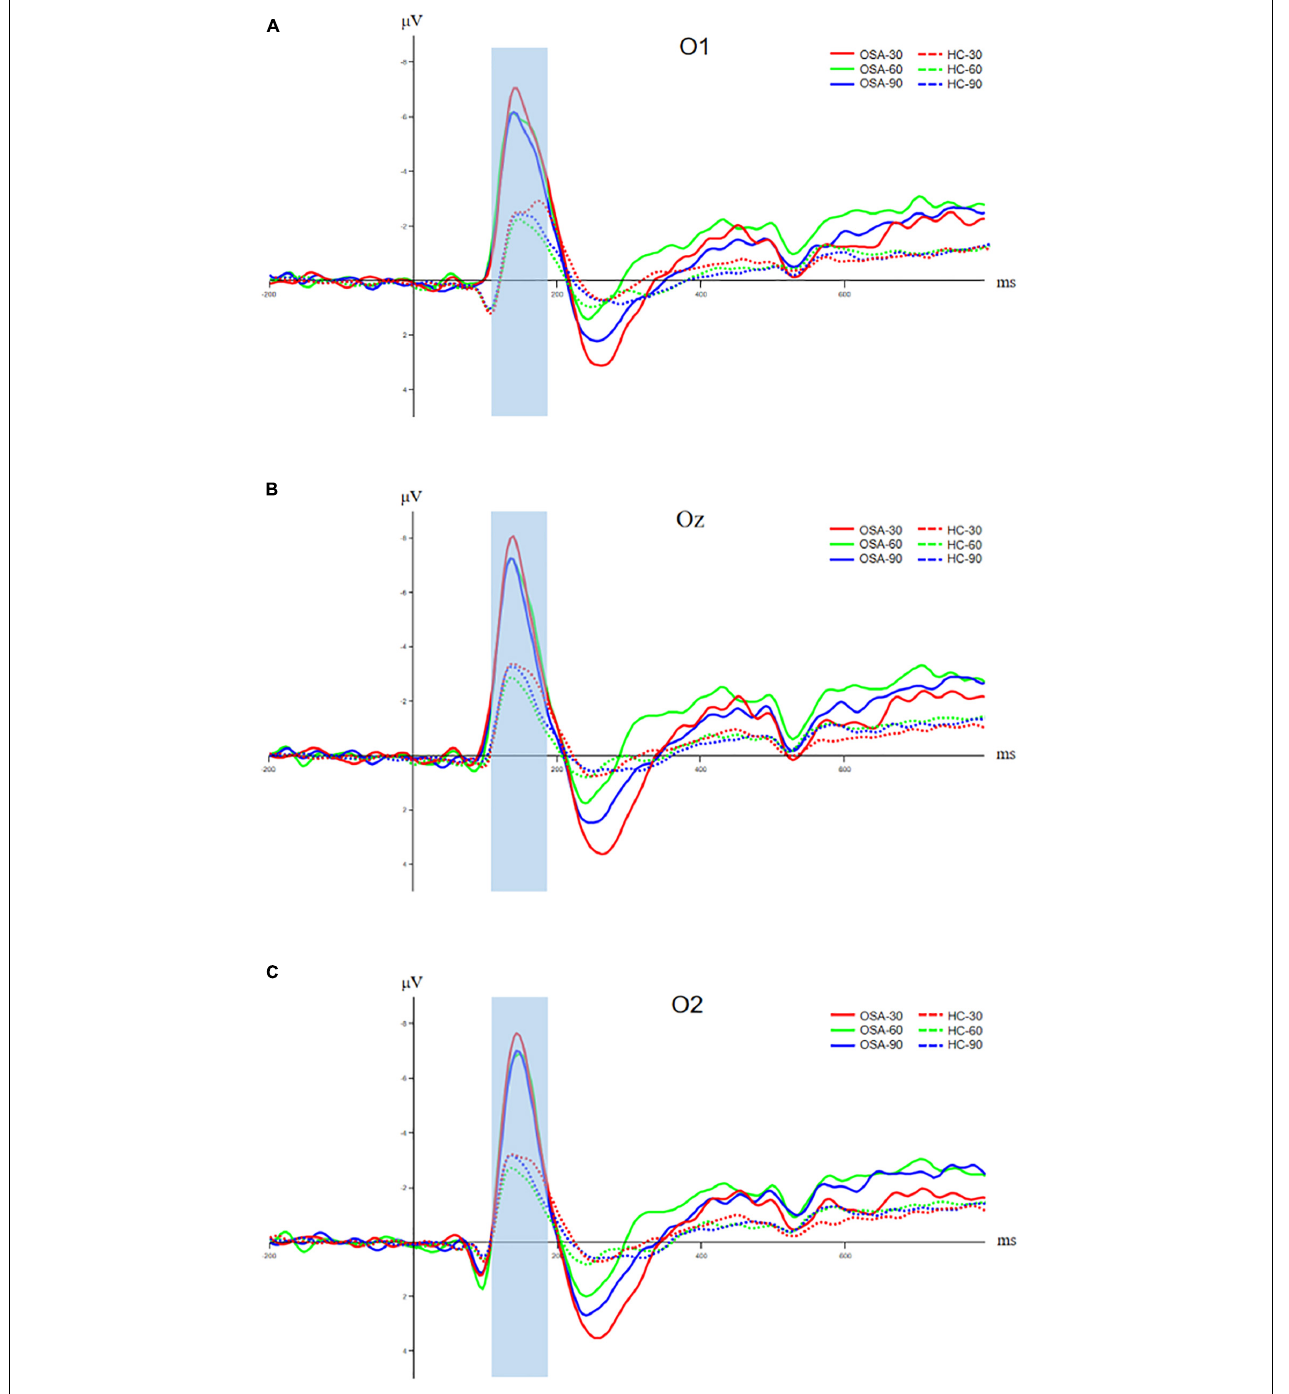
FIGURE 4 | Comparison of N100 components between OSA and healthy control group, (A) amplitude and latency of N100 component at O1 electrode; (B) amplitude and latency of N100 component at Oz electrode; and (C) amplitude and latency of N100 component at O2 electrode. The solid line is the OSA group, and the dotted line is the healthy control group. The red, green, and blue lines represent Jitter30, Jitter60, and Jitter90 conditions, respectively.